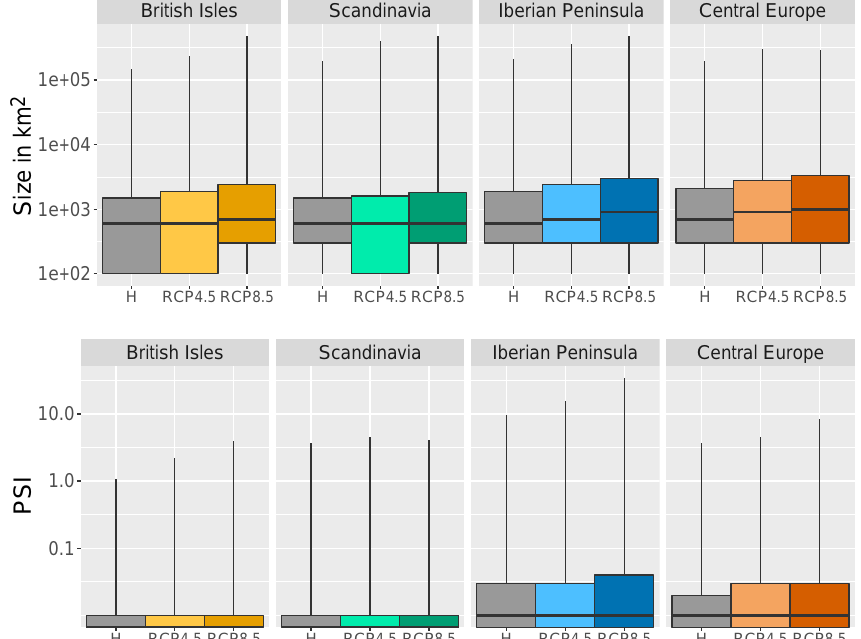
Figure 11. Size and strength distribution of detected sub-daily heavy precipitation events in four different European regions (British Isles, Iberian Peninsula, Scandinavia and Central Europe). The ensemble mean for the historical simulation (grey), the RCP4.5 (light colour) and the RCP8.5 (bright colour) scenario simulation for the period 2071–2100 are shown. The box plots show the median, 25th and 75th percentile and the whiskers span the range from the smallest to the largest